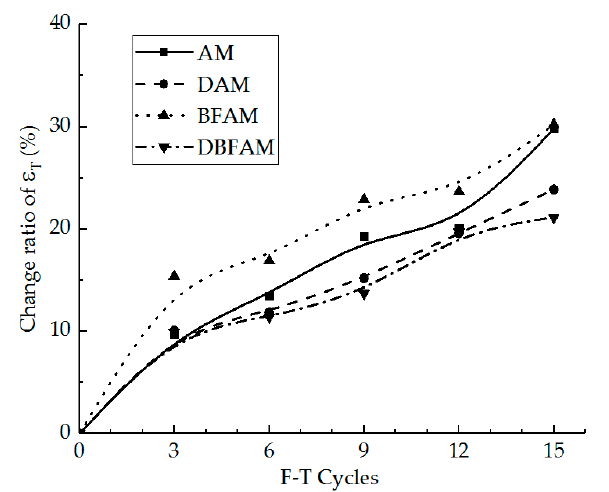
Figure 8. Change ratio of IDT failure strain under F–T cycles.